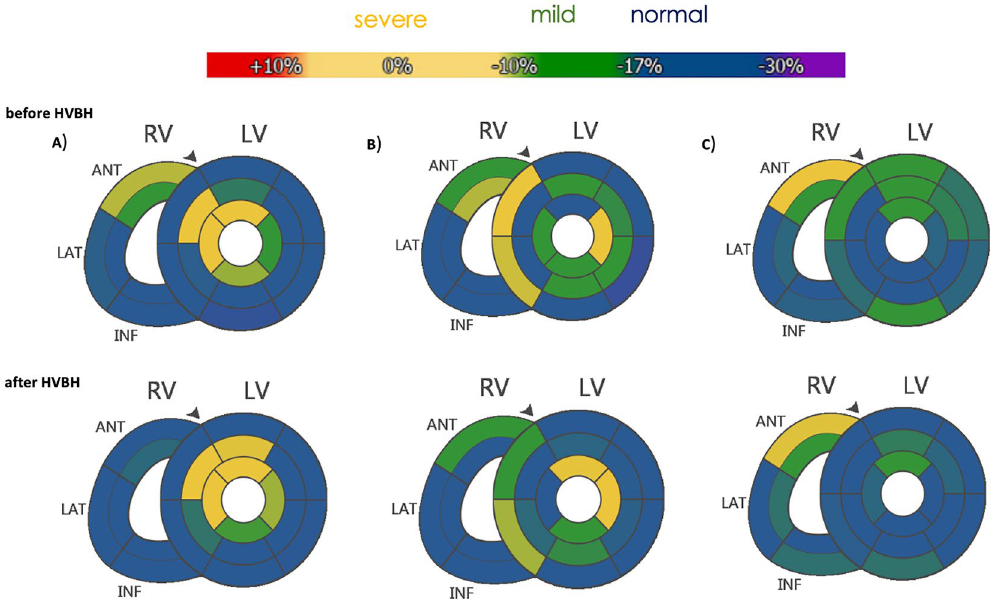
Figure 3. Examples of fSENC bull’s eye plots before HVBH (above) and after HVBH (below). ( A ) LAD stenosis with increased dysfunction after HVBH, ( B ) LCX stenosis with increased dysfunction after HVBH, ( D ) RCA stenosis with persistent dysfunction after HVBH.